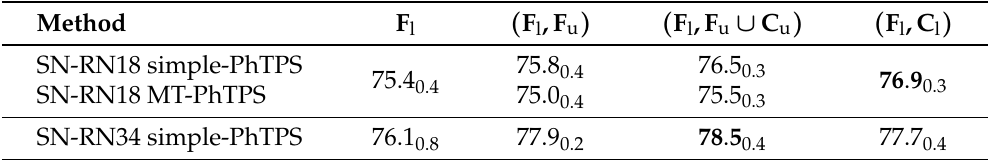
Table 4. Effects of an additional large dataset on supervised and semi-supervised learning on full- resolution Cityscapes val (mIoU/%). Tags F and C denote fine and coarse subsets, respectively. Subset indices denote whether we train with labels (l) or one-way consistency (u).